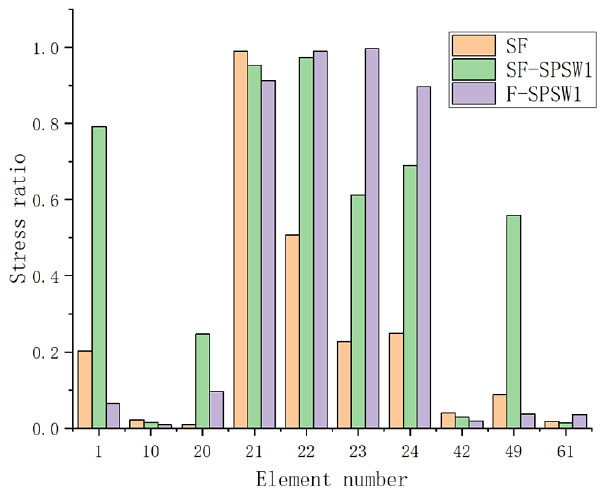
Figure 17. Story drift ratio of SF-SPSW 1 and SF 1.